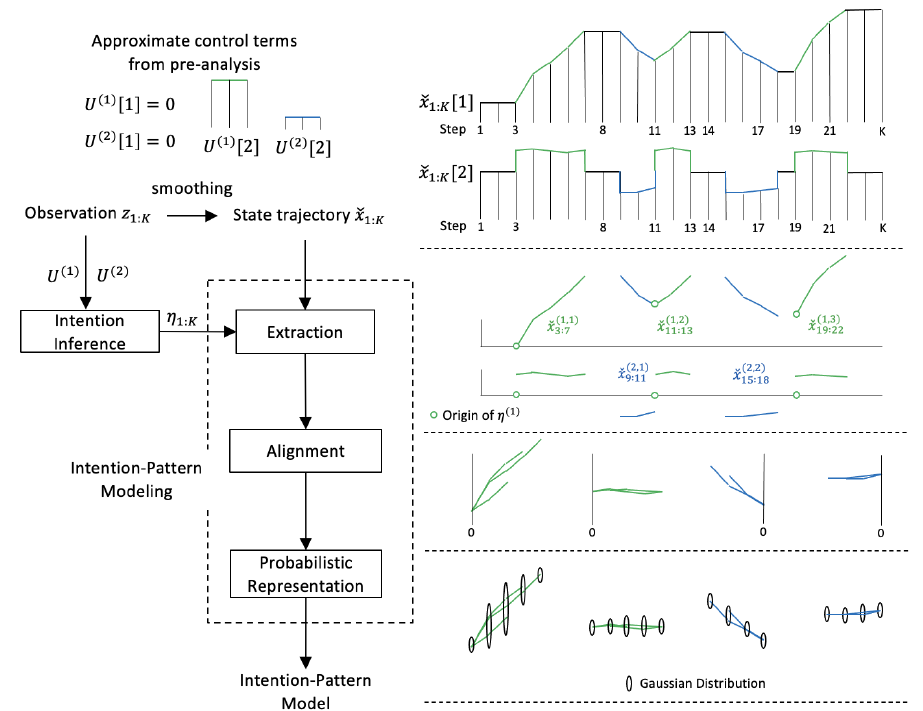
Figure 3. Construction of intention-pattern model. ( · )[ i ] represents the i th dimension of ( · )